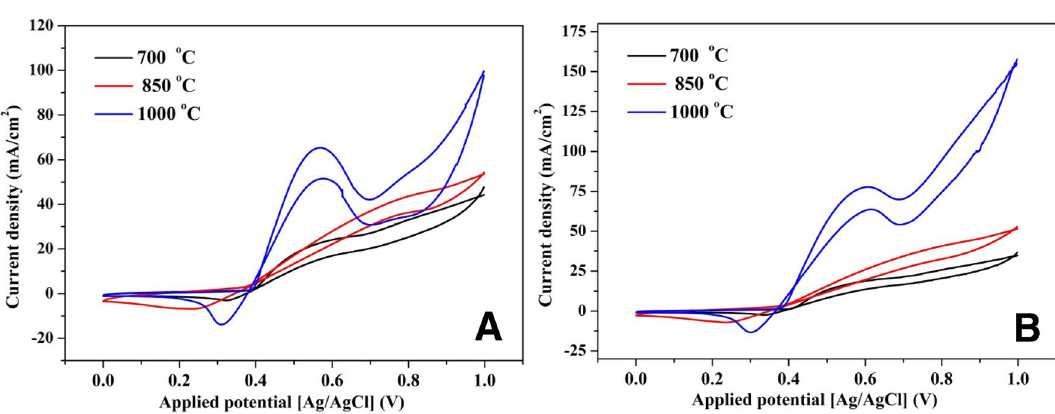
Figure 10. Influence of the calcination temperature on the electrocatalytic activity of the proposed NiMo- incorporated carbon nanofibers (10% Mo precursor) toward urea oxidation at different urea solution concentration, 1 M ( A ) and 2 M ( B ) at 50 mV/s scan rate and 25